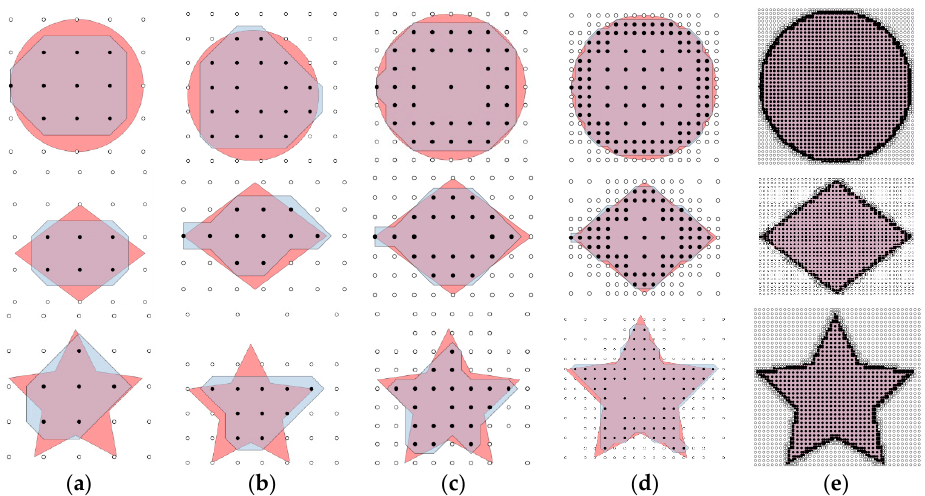
Figure 6. Different initial grid sizes for the proposed method with max level = 1. ( a ) initial grid size = 100; ( b ) initial grid size = 75; ( c ) initial grid size = 50; ( d ) initial grid size = 25; ( e ) initial grid size = 5.